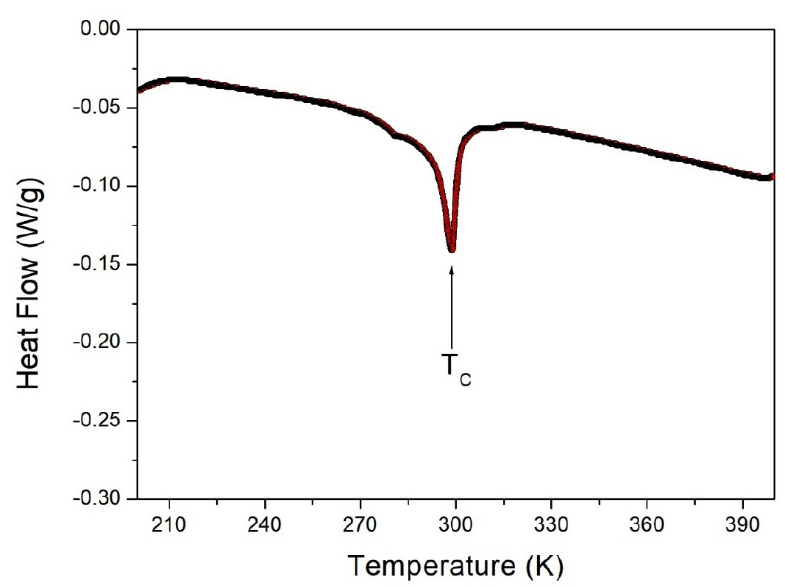
Figure 3. Differential scanning calorimetry curve of [NH 3 (CH 2 ) 5 NH 3 ]MnCl 4 .